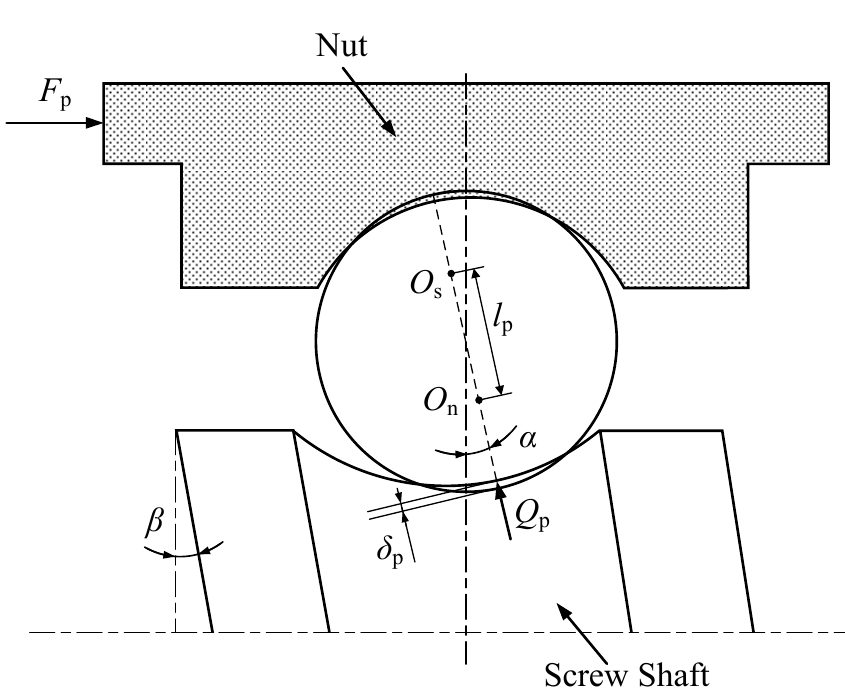
Figure 4. Deformation of a single ball when only preload is applied.